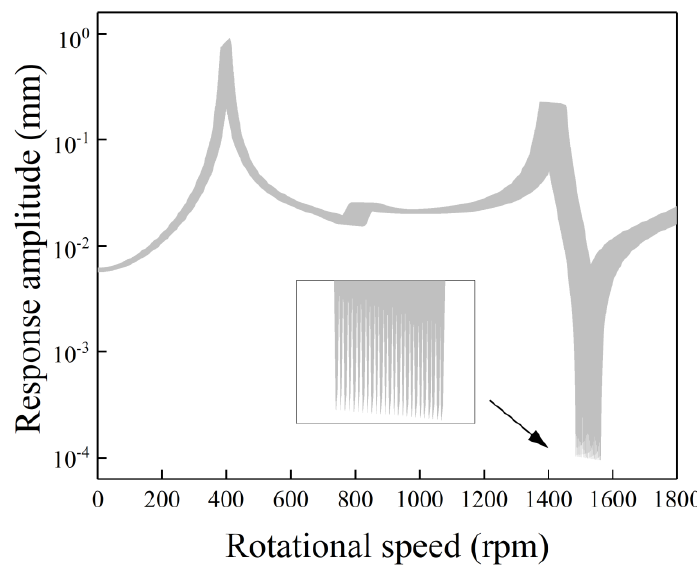
Figure 8. The bounds of uncertain gravity response versus rotational speed by the scanning method with a 10% deviation in bearing’s stiffness and a 5% deviation in Young’s modulus.